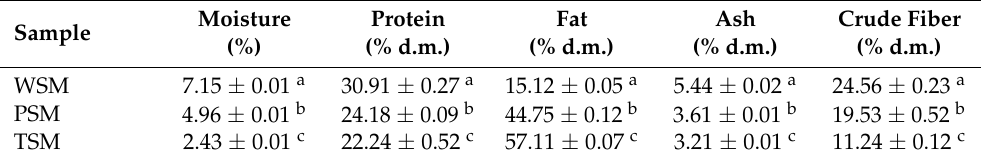
Table 1. Chemical composition of sunflower